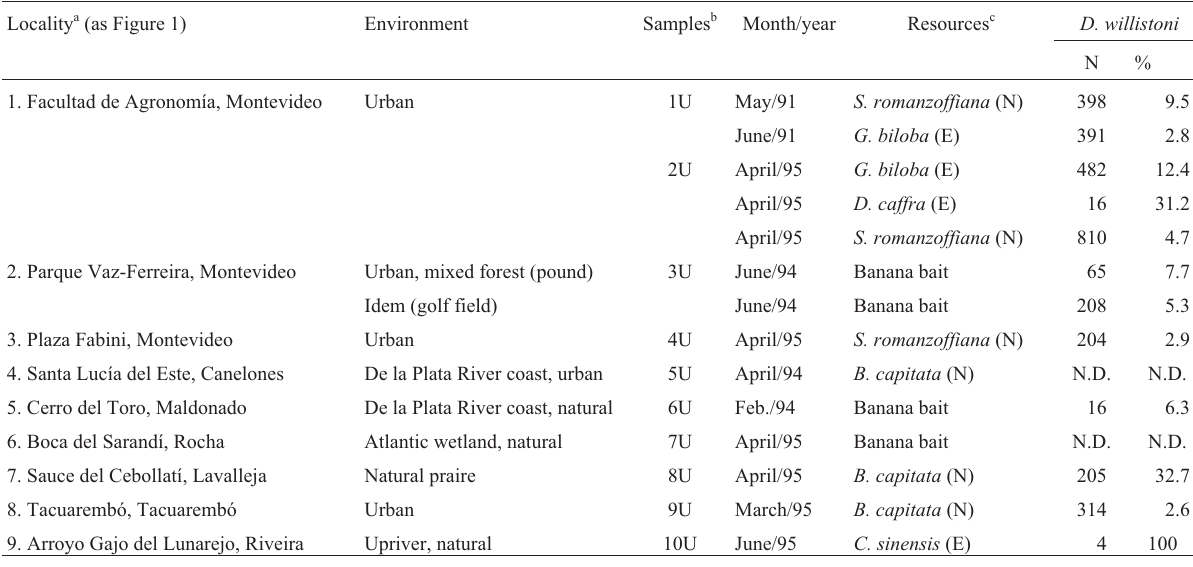
Table 1 - Sampled populations of Drosophila willistoni from Uruguay (see also Goñi et al ., 1997 and 1998). Locality a (as Figure 1)